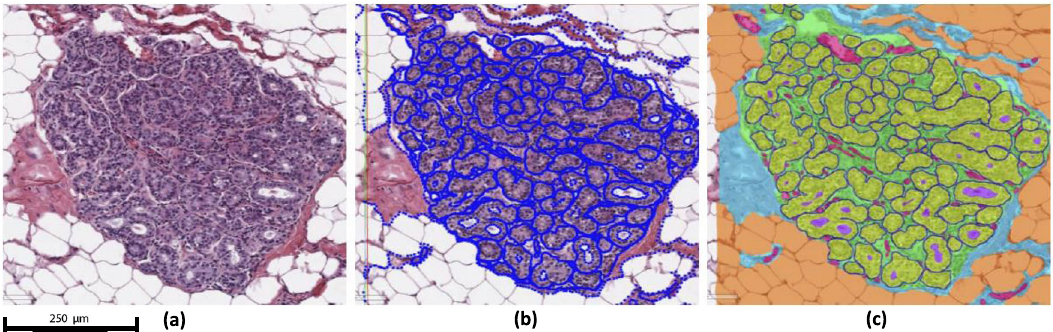
Fig. 5 Annotation process example: An example demonstrating the process of annotation. A single TDLU region ( a ) is selected to be fully annotated ( b ). The annotations are then converted to a ground truth map ( c ) using ASAP. The classes are mapped as follows: epithelium (yellow), intralobular stroma (green), extralobular stroma (blue), lumen (purple), adipose tissue (orange), vessel (pink). The border class (dark blue) was separately added in a post-processing step.